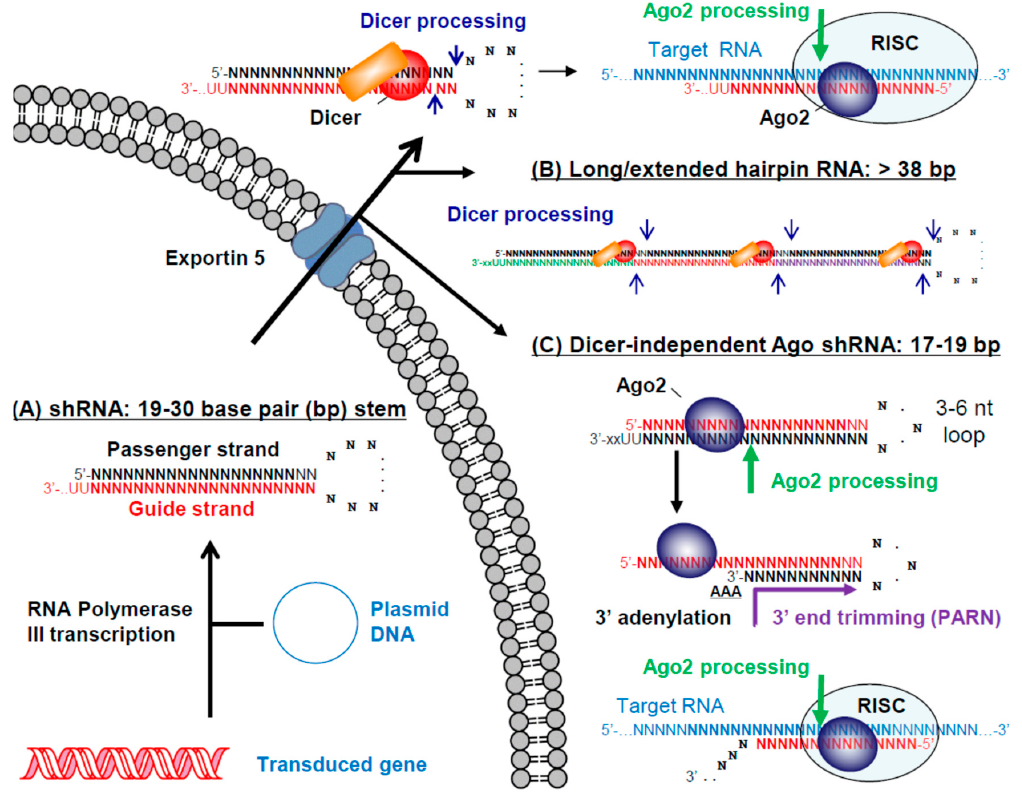
Figure 4. Therapeutic short hairpin RNAs (shRNAs). ( A ) shRNAs with 19 to 30 base pair (bp) stems and variable loop sequences can be transcribed from an integrated gene or transfected plasmid